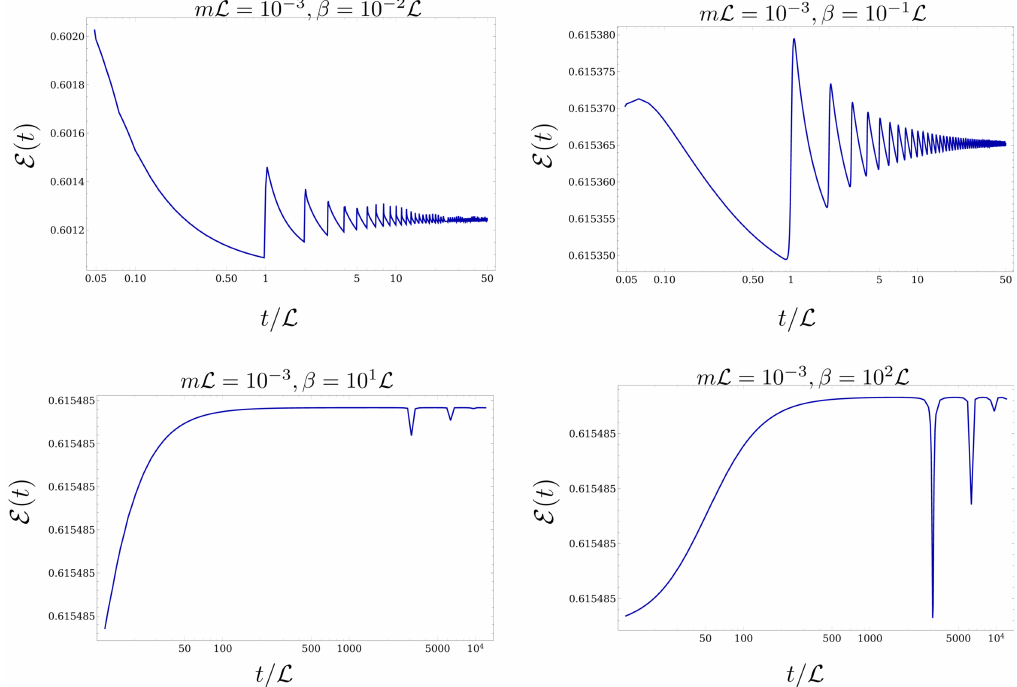
Figure 14 . Temperature effect on long time behavior of logarithmic negativity E . We take N =1501 , = N + N =1+1 N A A L 1( R 1) A L 2( R 2) L ( R )